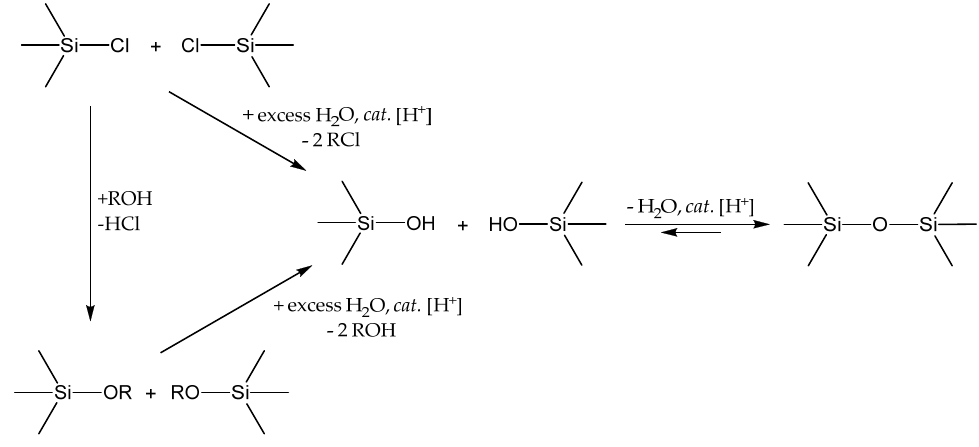
Table 4. Piers ‐ Rubinsztajn (PR) reaction of ethoxysilanes (Si ‐ OEt) and hydridosil(ox)anes (Si ‐ H) cat